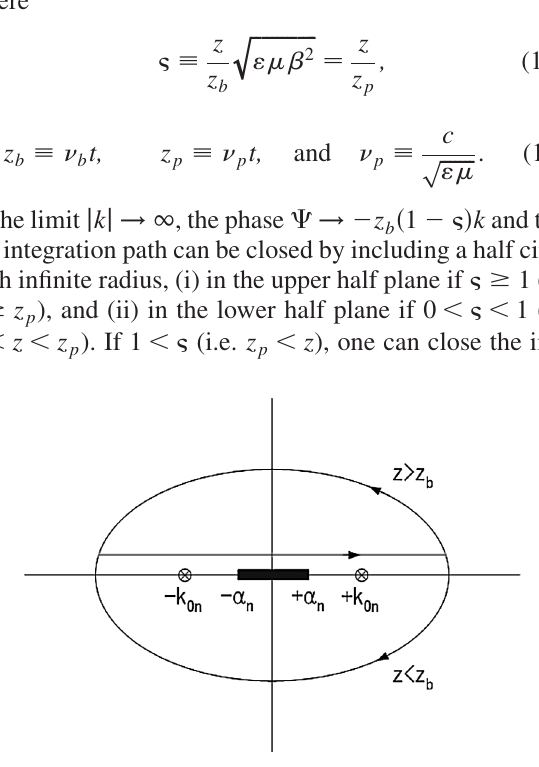
FIG. 2. Contours for integration in the complex k plane for transient